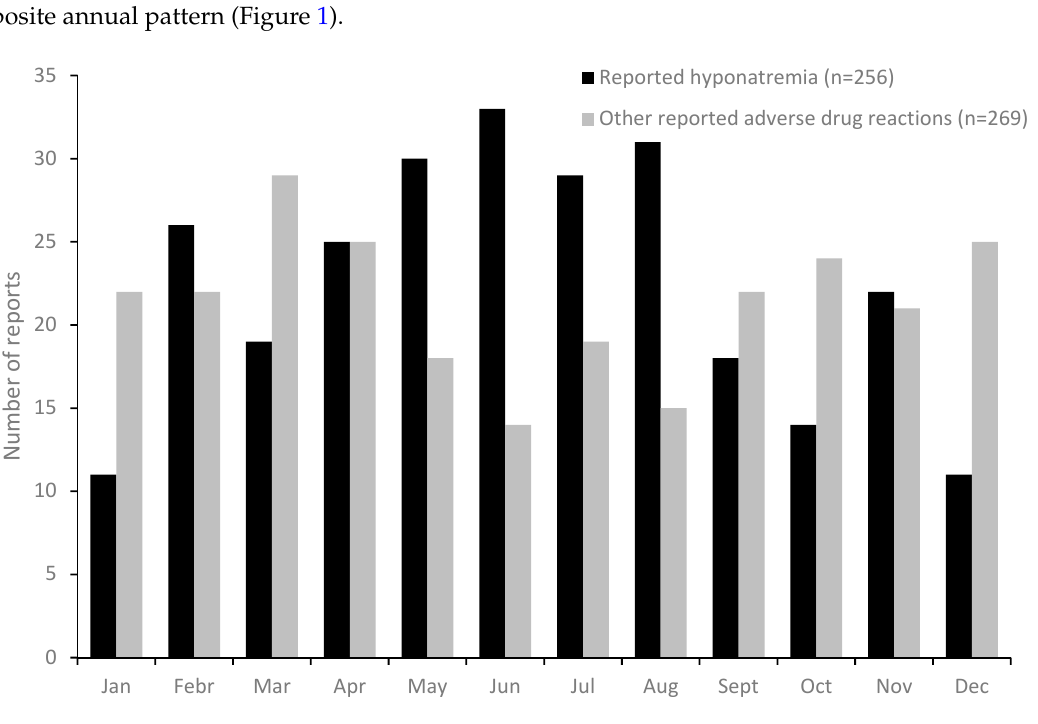
Figure 1. Annual seasonal pattern of reported hyponatremia and randomly collected control reports with other adverse drug reactions, in Sweden.